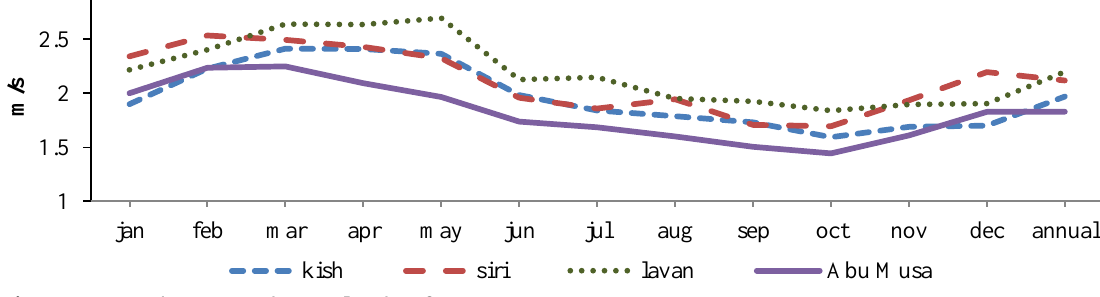
Figure 7. Wind magnitude in islands of Hormozgan